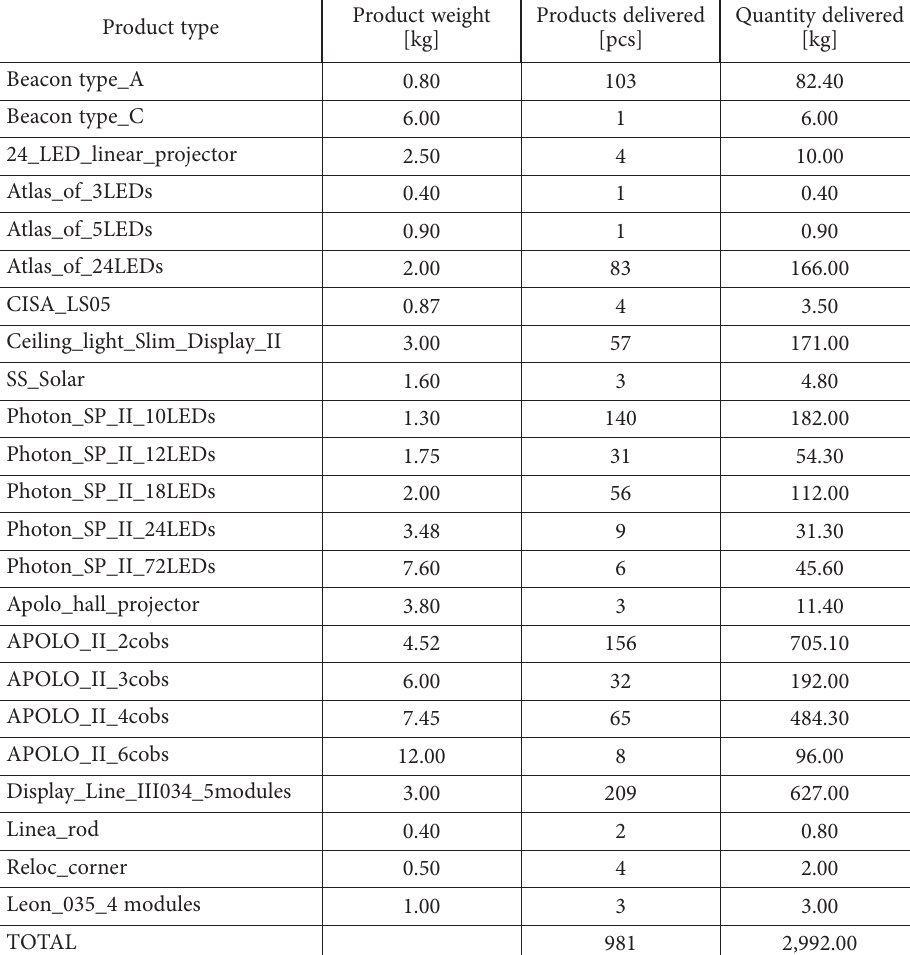
Table 1. Calculation model for a monthly declaration to CCR